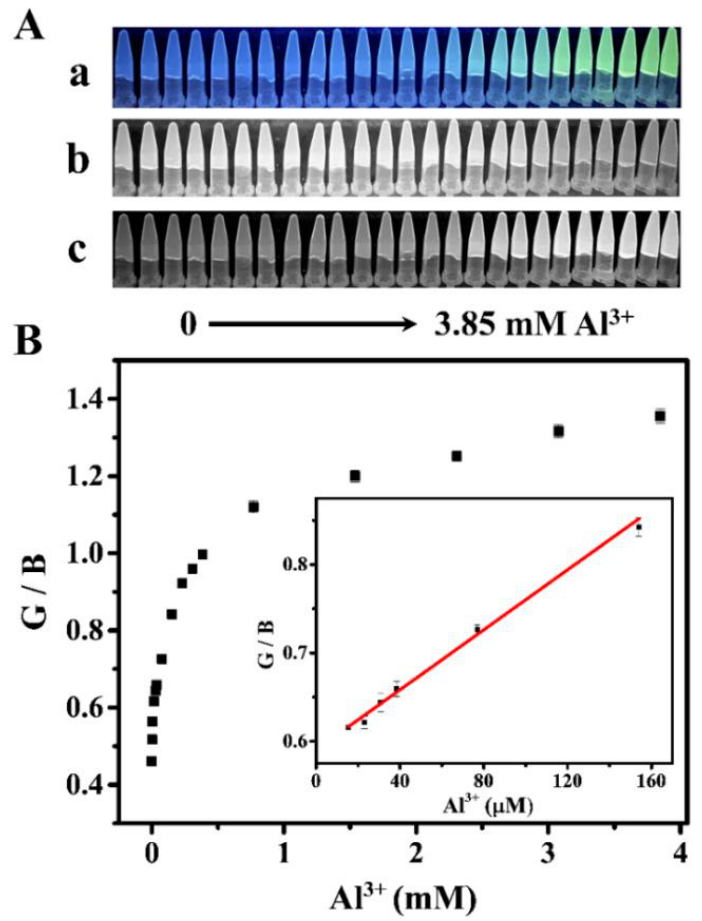
Figure 5. Images of the CDs solutions obtained by using a smartphone under a 360 nm UV lamp. ( a ) Different concentrations of Al 3+ were added into the sample; ( b ) blue channel content of the image and ( c ) green channel ( A ). ( B ) G/B as a function of the Al 3+ concentration. The inset shows the linear fit of G/B as a function of the Al 3+ concentration.